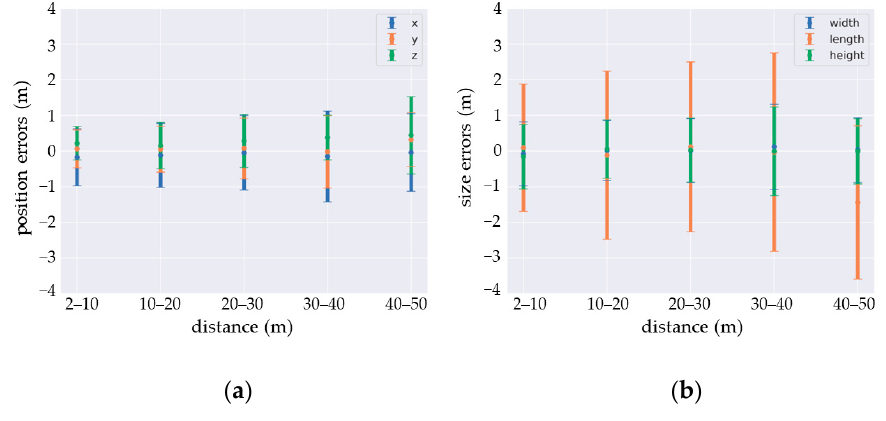
Figure 12. Estimation errors: ( a ) position and ( b ) size.